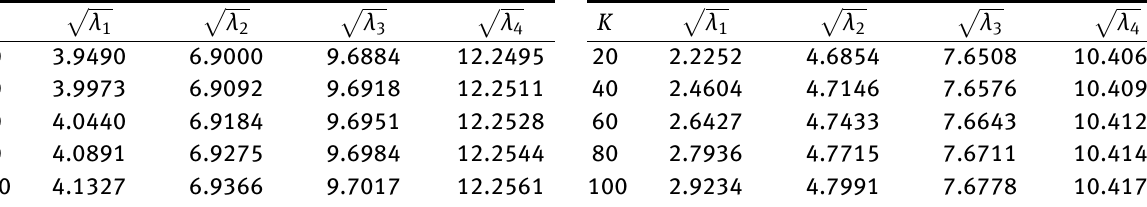
Table 25: Frequency parameter Winkler modulus